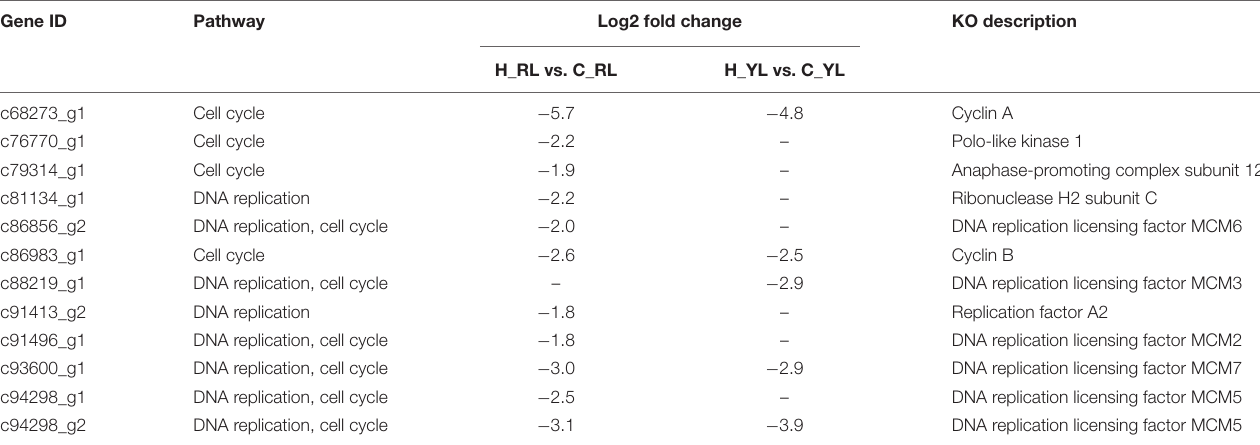
TABLE 2 | Differentially expressed genes (DEGs) in cell cycle and DNA replication